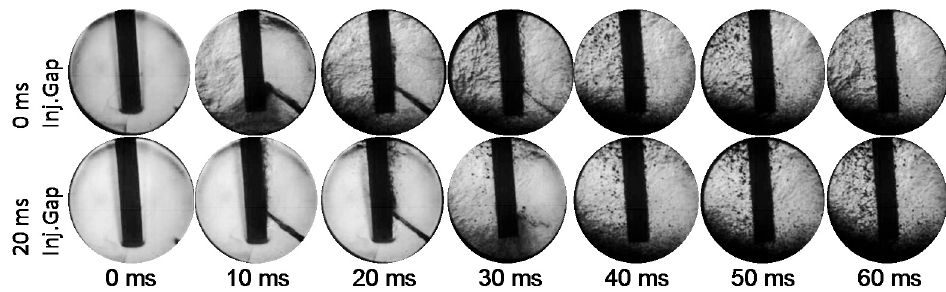
Figure 11. Mixture distribution for 0 ms and 20 ms injection gaps for 70/30 diesel/CNG composition.